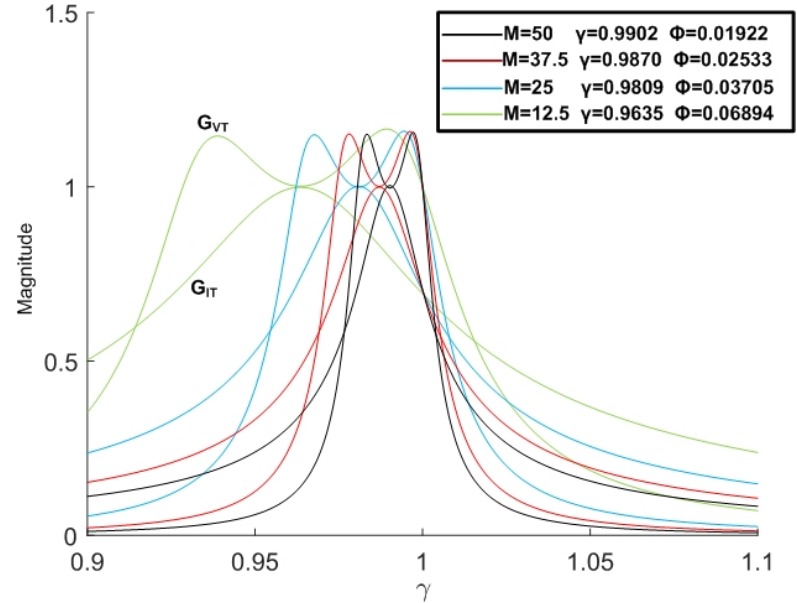
Figure 11. Compensation circuit behavior for frequency variations.